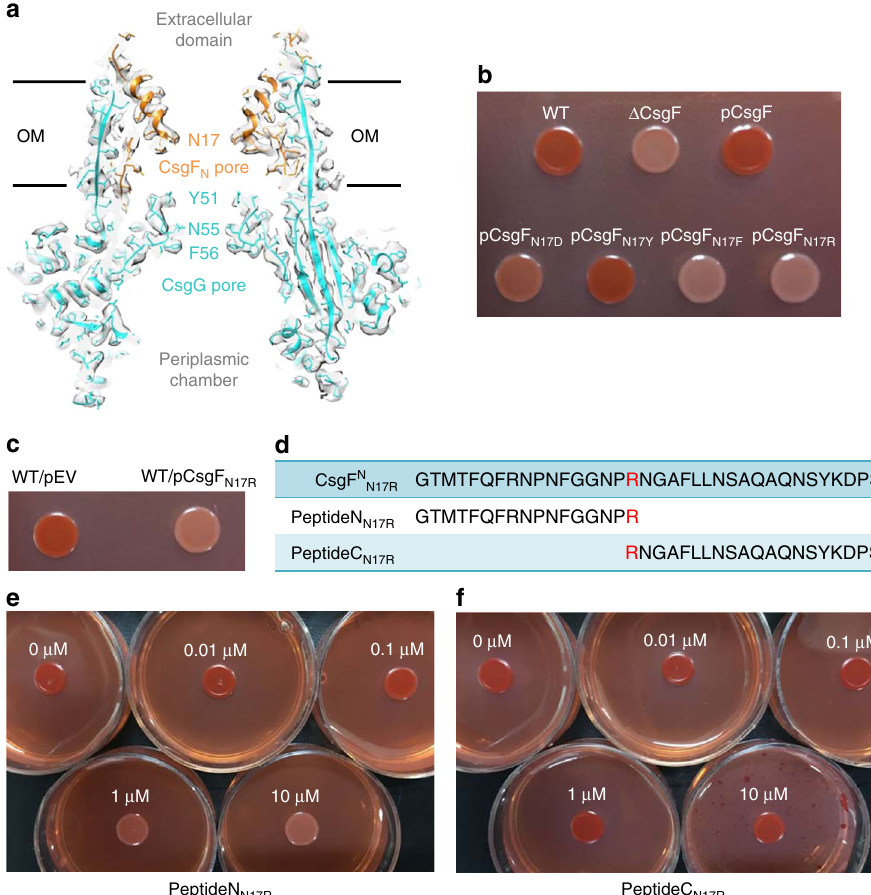
Fig. 2 Dual-pore structure of CsgFG complex and analysis of peptide inhibition. a Section view of CsgFG complex. The atomic model was superimposed with the corresponding cryoEM density map. Models of CsgG and CsgF are in cyan and orange, respectively. b Congo red secretion assay for mutations of the asparagine residue of CsgF N into four different kinds of amino acids in the Δ CsgF strain. Source data are provided as a Source Data fi le. c Congo red secretion assay for the N17R-mutated CsgF in the wild type (WT) strain. Source data are provided as a Source Data fi le. d Schematic diagram of the synthesized peptides, PeptideN N17R and PeptideC N17R . The N17R mutation is shown in red. e Congo red secretion assay for the WT strain treated with PeptideN N17R at concentrations ranging from 0.01 to 10 µ M. Source data are provided as a Source Data fi le. f Congo red secretion assay for the WT strain treated with PeptideC N17R at concentrations ranging from 0.01 to 10 µ M. Source data are provided as a Source Data fi